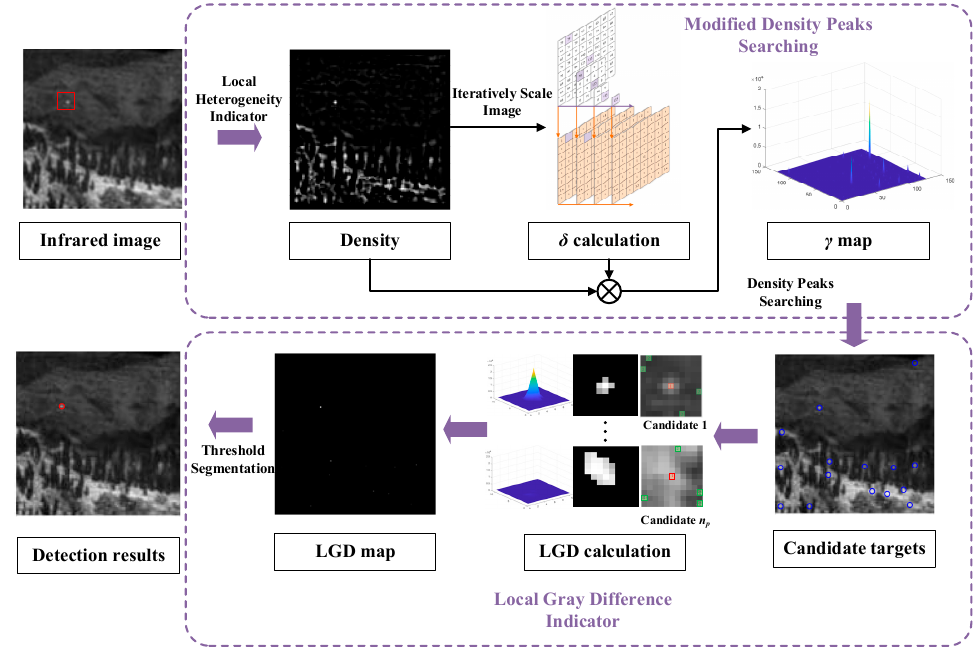
Figure 2. Flowchart of the proposed method.